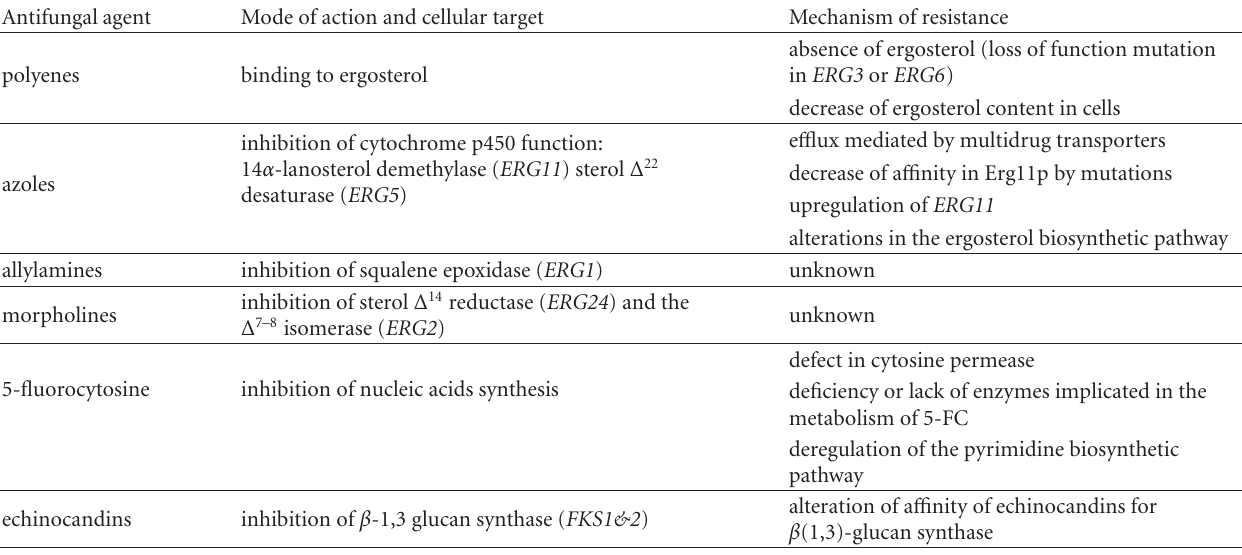
Table 2: Nature, target, mode of action, and fungal resistance mechanisms of the major antifungal drugs used in human